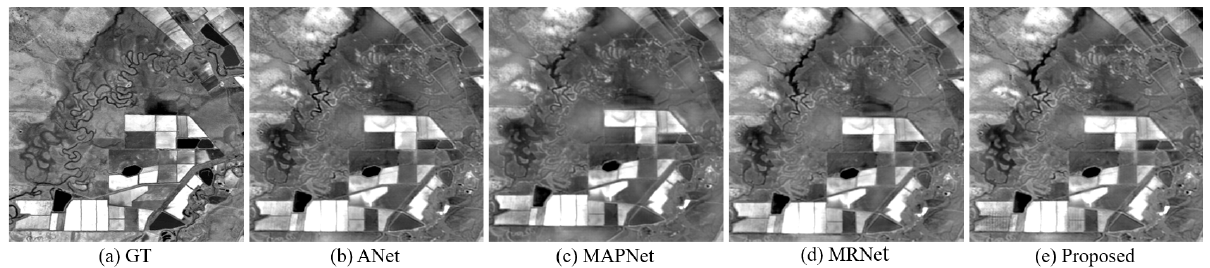
Figure 10. The results on the CIA dataset of these comparative experimental methods.